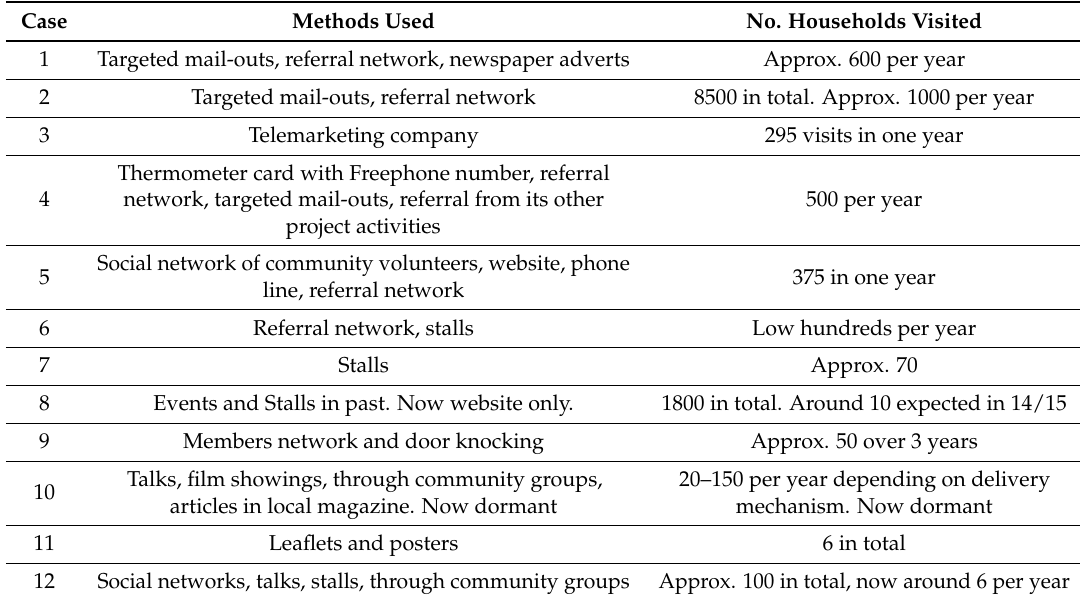
Table 2. Methods used to reach householders and households